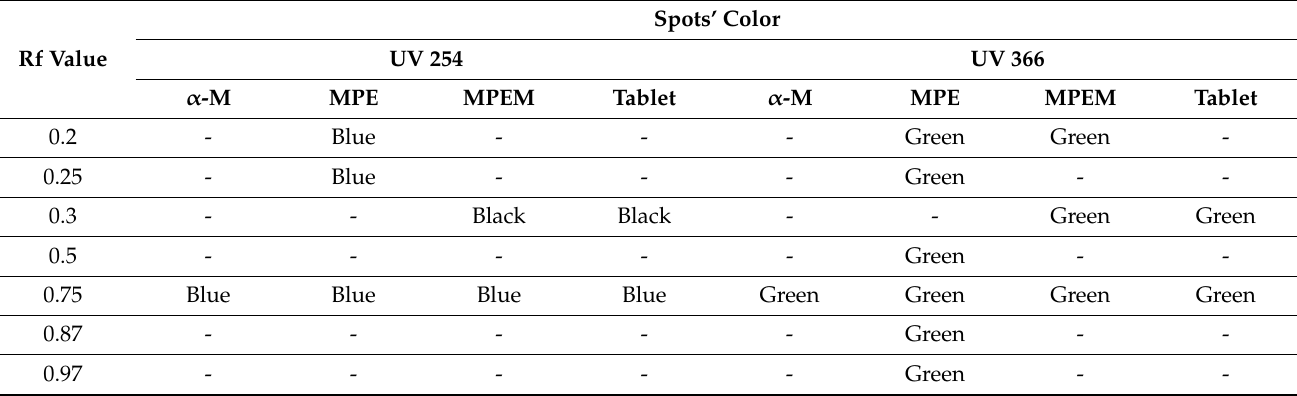
Table 8. Thin-layer chromatography profile of each fabrication raw product.